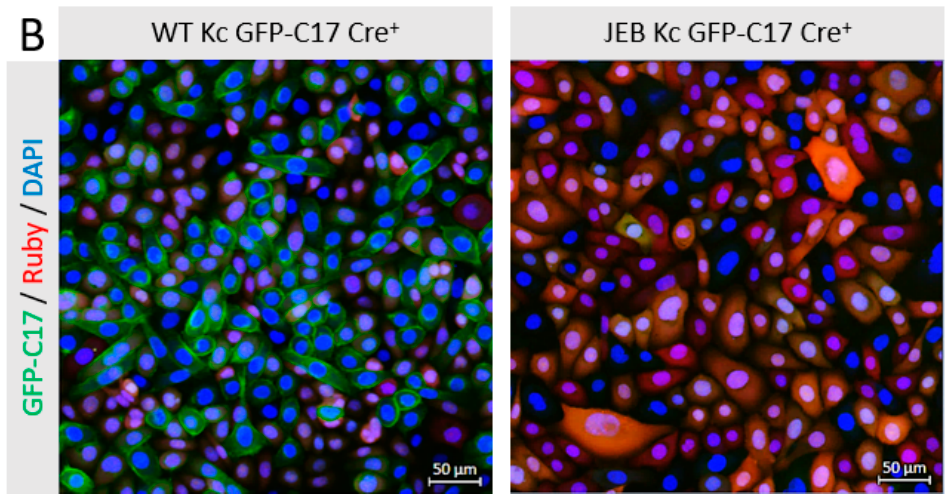
Figure 3. GFP-C17 expression and localization in WT and JEB keratinocytes. ( A ) Western blot analysis of cell lysates of WT Kc GFP-C17 revealed the expression of the full-length GFP-C17 fusion protein detectable upon GFP and C17 staining above the band corresponding to wild-type C17 (180 kDa). The shed extracellular C17 domain has a molecular weight of 120 kDa. Lysates from WT keratinocytes without GFP fusion served as a negative control. β -tubulin (50 kDa) was used as a loading control. ( B ) Fluorescence microscopic analysis of WT Kc expressing GFP-C17 after Cre-recombinase-treatment prior to GFP pos selection via FACS revealed the accurate localization of the fusion protein within the plasma membrane. As expected, JEB cells expressing GFP-C17 mut emitted no GFP signal. Cells were stained with 4 ′ , 6-Diamidino-2-phenylindol (DAPI) for cell nuclei visualization.